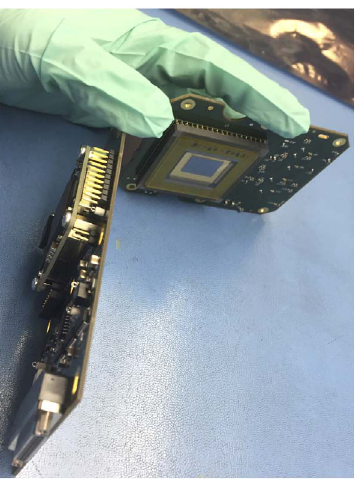
Fig. 11. The Teledyne e2v CIS115 detector and LASP Compact Camera and Processor (CCAP) that fl ew successfully on a NASA sounding rocket in 2018; CCAP is now fl ying on the CSIM CubeSat launched in 2018.